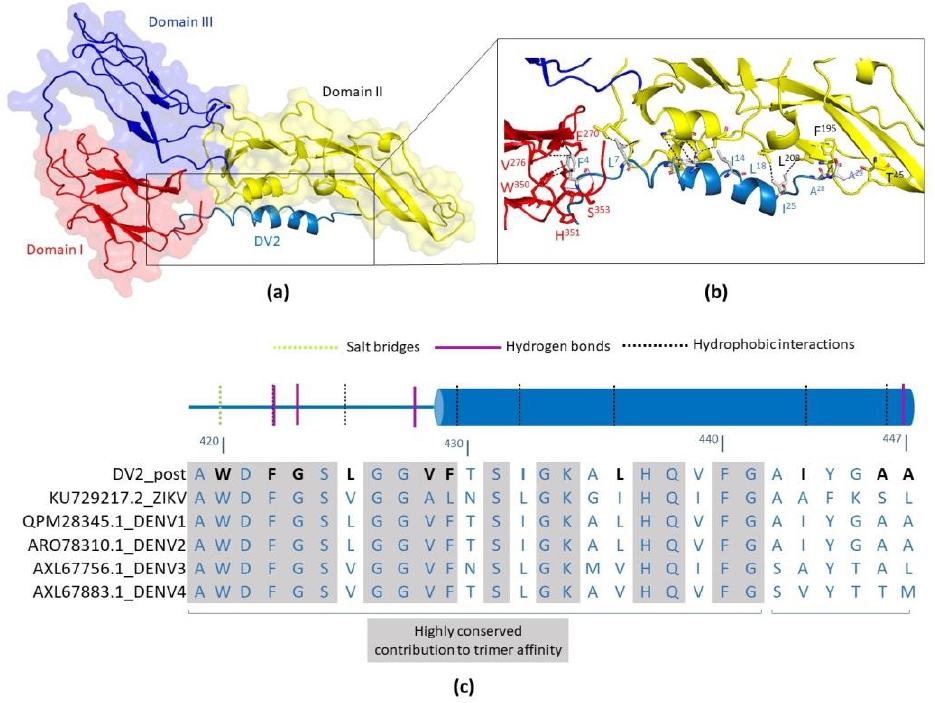
Figure 1. Prediction of DV2 peptide and ZIKV E protein interactions based on in silico docking analyses. The structural model of ZIKV E protein in postfusion conformation (based on the structural coordinates from PDBs 3G7T and 1OK8) was used for the analysis. The protein is shown in surface mode highlighting domain I, II, and III, displayed as red, yellow, and blue colored cartoons, respectively. The DV2 peptide is represented using a sky-blue-colored cartoon. ( a ) According to docking results, the peptide interacts with EDI and EDII, in the postfusion conformation. ( b ) Detailed view of the interacting residues between the ZIKV E protein and the DV2 peptide, predicted by the PLIP program. Residues are shown as colored sticks; sky blue has been used for the DV2 peptide, salmon for DI, and yellow for DII residues. ( c ) Representation of residues 420 – 447 of the DV2 peptide and their interactions with the ZIKV E protein. The amino acid sequence alignment of the DV2 peptide with the respective sequences of the envelope protein of ZIKV and DENV (types 1 to 4) is shown below. The residues of the peptide that interact with the postfusion conformation are highlighted in bold black.